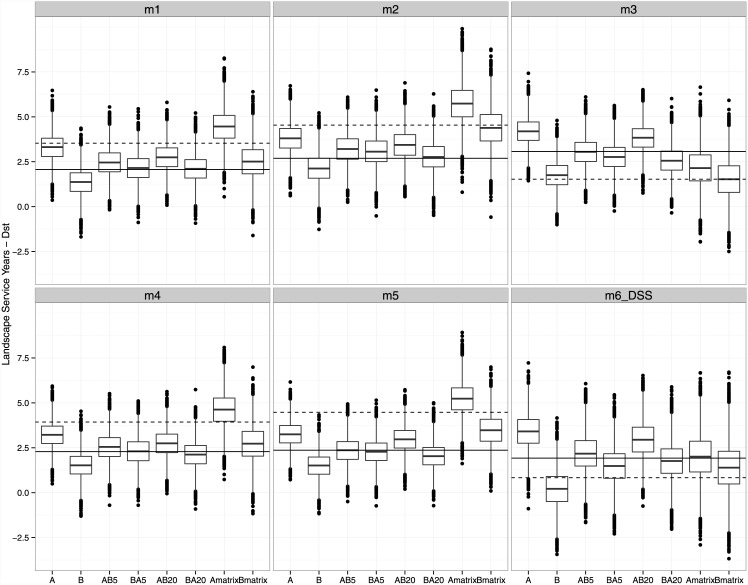
Landscape Service Years for average genetic divergence among breeding groups (Dst).Solid horizontal line represents the number of credits available in the bank, prior to a trade, assuming a static matrix and the dashed horizontal line is the number of credits available under a declining matrix. Boxplots of bootstrapped credit values remaining after each trade, with bars represent median values, the box represents the upper and lower 25th quartile, whiskers represent max/min values excluding outliers, and dots represent outliers, or values 1.5 x 25th quartile.